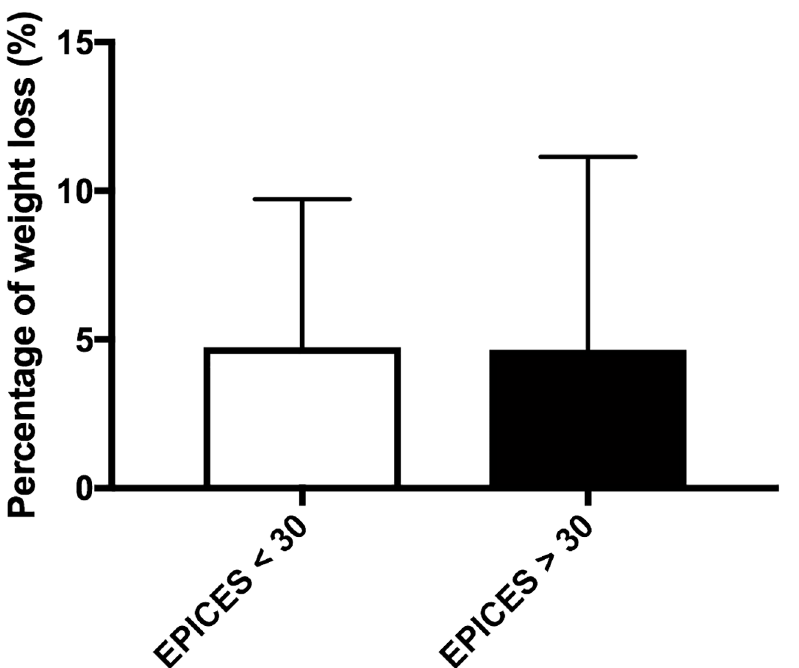
Fig 2. Percentage of weight loss according to EPICES